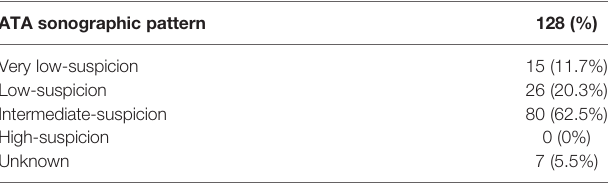
TABLE 2 | ATA sonographic pattern of